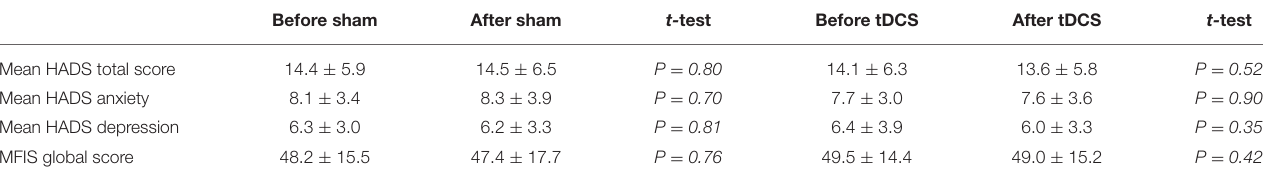
TABLE 4 | Neuropsychological results (Mean ± SD) before and after sham and active tDCS. Before sham After sham t- test Before tDCS After tDCS t-